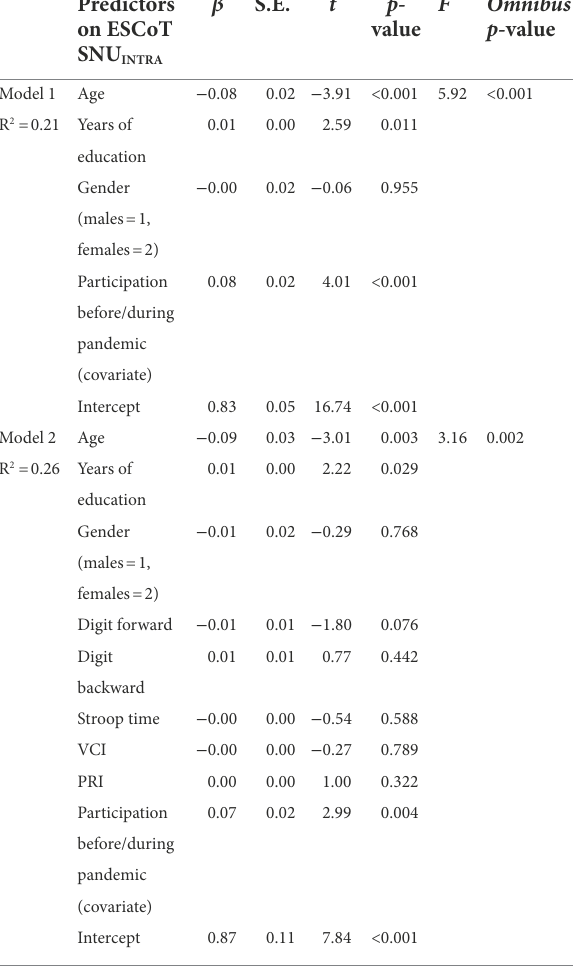
TABLE 7 Multiple regression results for predictors of ESCoT SNU INTRA total score. Predictors on